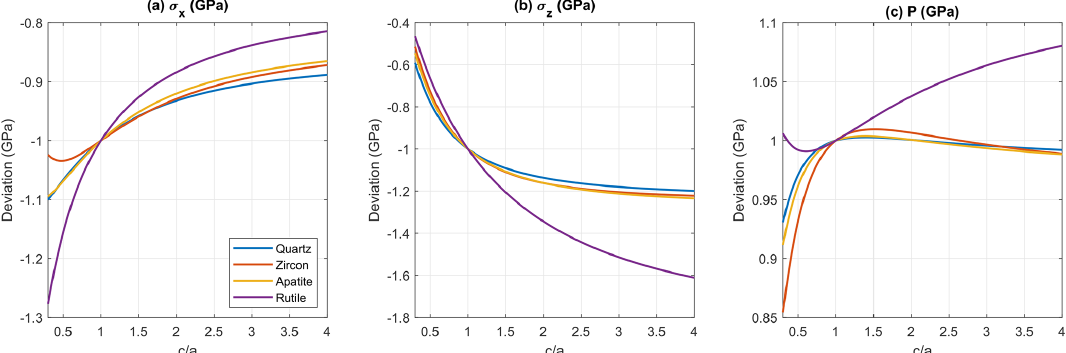
Figure 3. Effect of geometrical aspect ratio of spheroidal inclusion along c and a axes on residual stress ( c/a ). (a, b) Stresses σ res xx and σ res zz as a function of the geometrical c/a ratio for quartz, zircon, apatite, and rutile inclusions. To isolate the effects of aspect ratio, the eigenstrain are set to produce σ res xx = σ res zz = − 1GPa for the reference spherical inclusion. Any deviation from − 1GPa is due to shape changes. (c) Pressure as a function of the c/a ratio. Here, the crystallographic c axis is aligned parallel to the long axis for prolate inclusions and the short axis for oblate inclusions. The quartz elastic stiffness tensor is from Heyliger et al. (2003), zircon and diamond are from Bass (1995), rutile is from Wachtman et al. (1962), and apatite is from Sha et al. (1994). The isotropic stiffness tensor of the almandine host is from Milani et al.